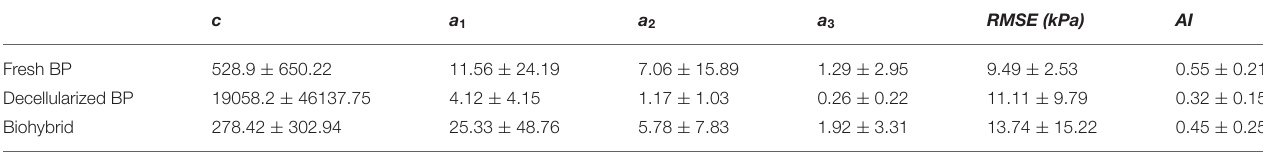
TABLE 1 | Fung model parameters and anisotropy metric.